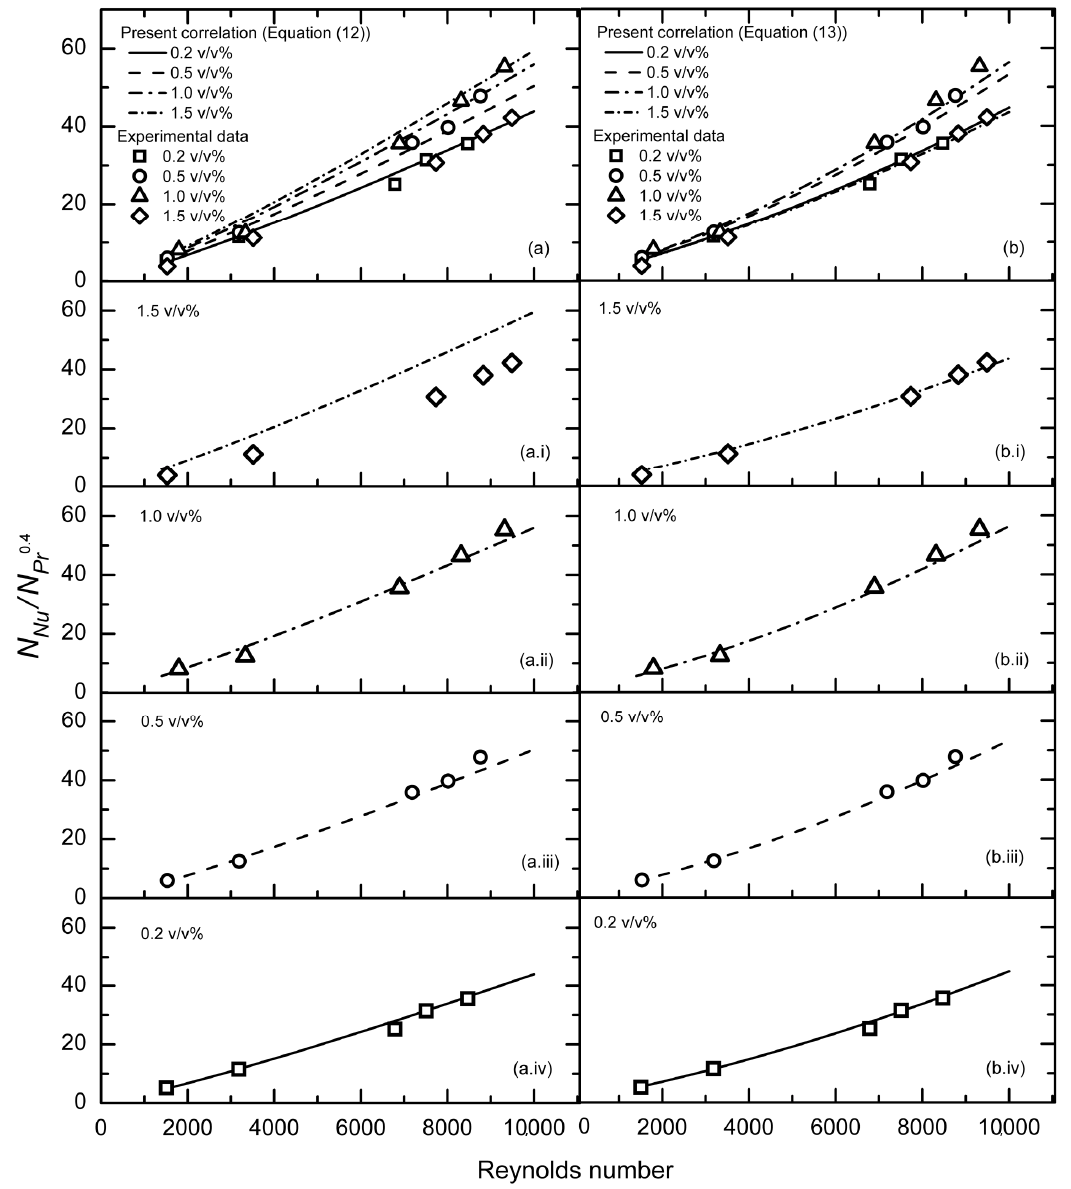
Figure 13. Plots of N Nu / N 0.4 versus N Re . The symbols are the experimental data and the curves were Pr calculated by Equation (12) in ( a – a.iv ) and Equation (13) in ( b – b.iv ). Cumulative results ( a , b ), and the results of NFs with an NP concentration of 1.5 v / v % ( a.i , b.i ), 1.0 v / v % ( a.ii , b.ii ), 0.5 v / v % ( a.iii , b.iii ), and 0.2 v / v % ( a.iv , b.iv ). Legends as shown in ( a , b